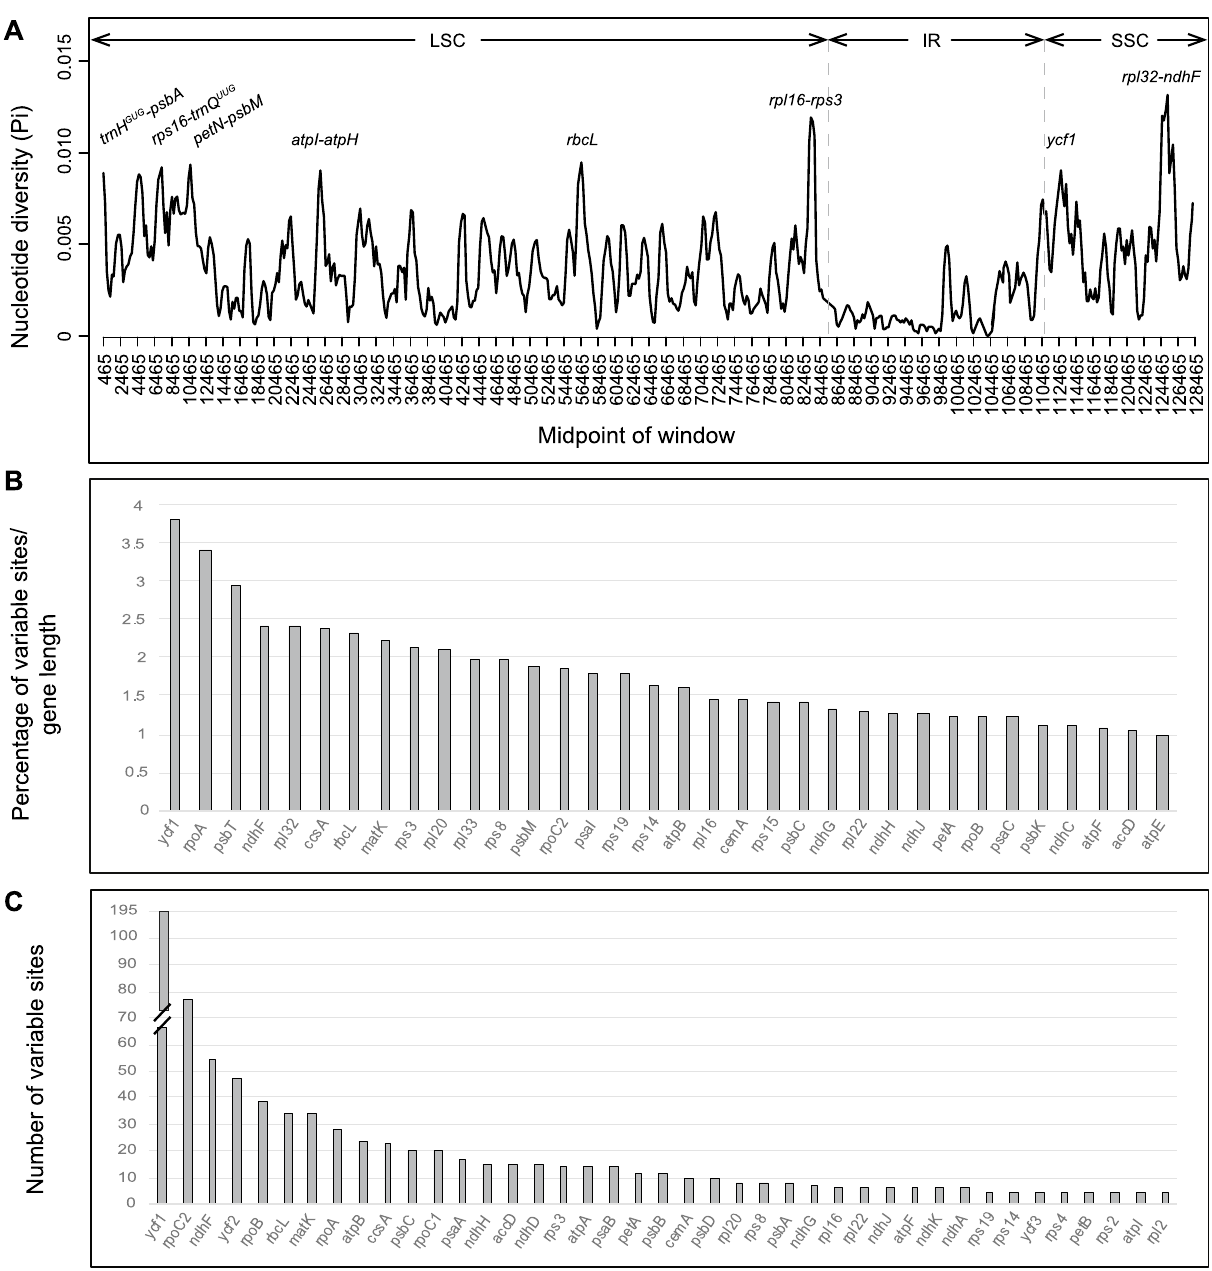
Figure 1. ( A ) Sliding window analysis of the chloroplast genomes of 20 Mikania plastomes (i.e., 19 sequenced here plus M. micrantha , NC031833.1) (window length: 800 bp, step size: 200 bp). X-axis, position of the midpoint of a window; Y-axis, nucleotide diversity (π) in each window. ( B,C ) Most variable protein-coding genes within the 20 Mikania plastomes. ( B ) Genes with up to 1% of variable sites. ( C ) Genes with up to five variable sites.